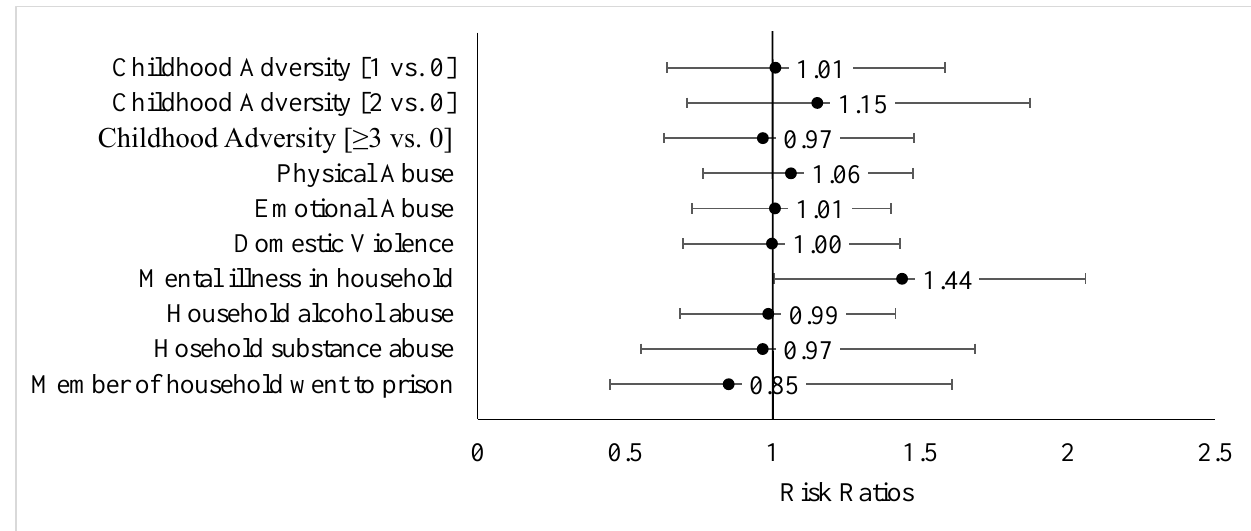
Figure 1. Adjusted associations of childhood adversity, cumulative and individual indicators, with early age at menarche (<12 years), relative risk ratios, and 95% confidence intervals. Notes: Models for cumulative childhood adversity indicators included complete responses for each of the seven adversity questions (N= 343). Models for individual childhood adversities included complete responses per indicator (range: N = 373 to 388); reference endorsed vs. not endorsed. All models adjusted for age at interview, race/ethnicity, education, and language dominance.